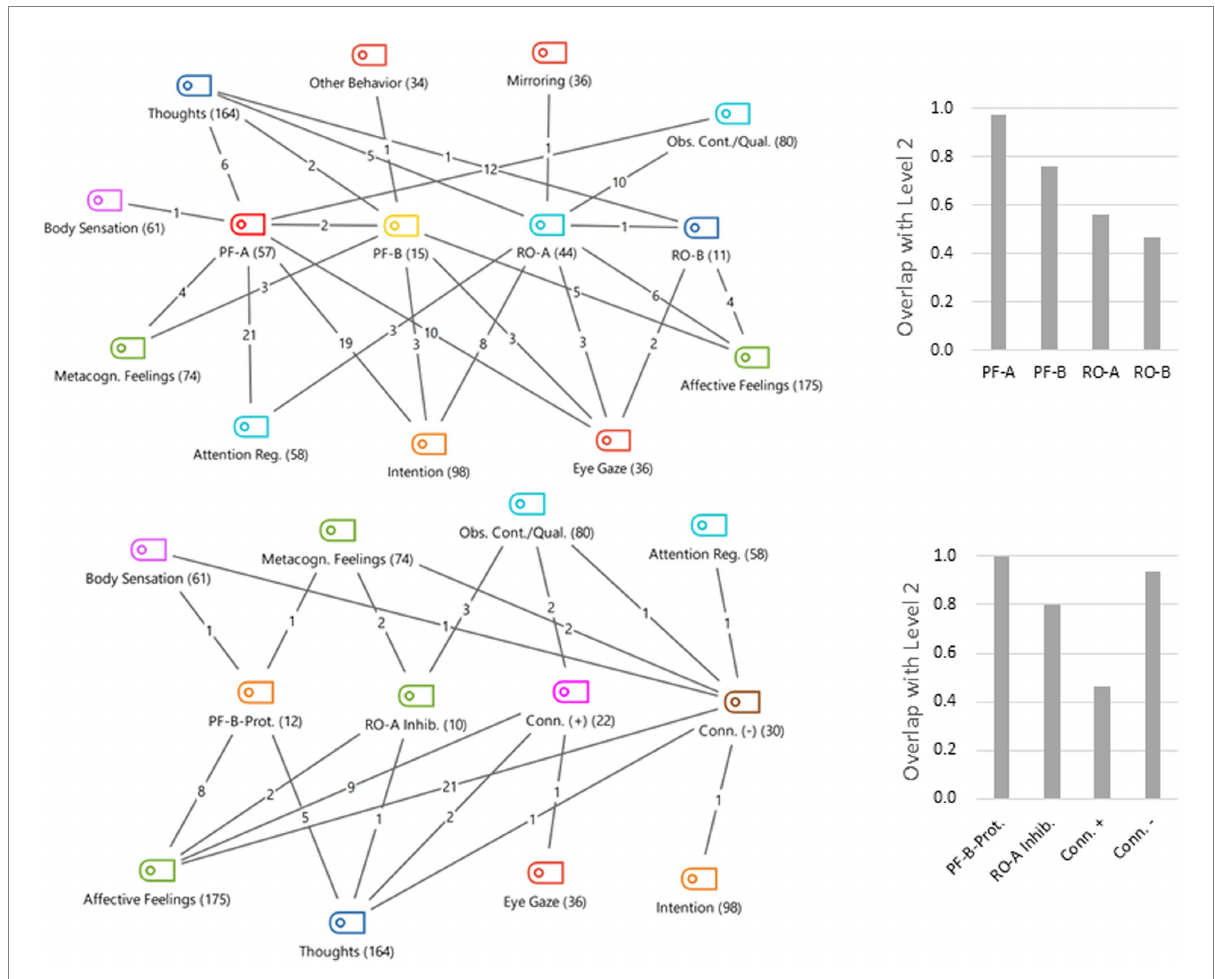
FIGURE 2 Code relations between levels 2 and 3. Level 3 categories are placed in the middle of the code maps, surrounded by level 2 categories that overlap with them. The total frequencies are in brackets, the overlaps are on the lines. From interlevel relations, only those for level 3 are shown. The diagrams show the portion of overlap between level 2 and level 3